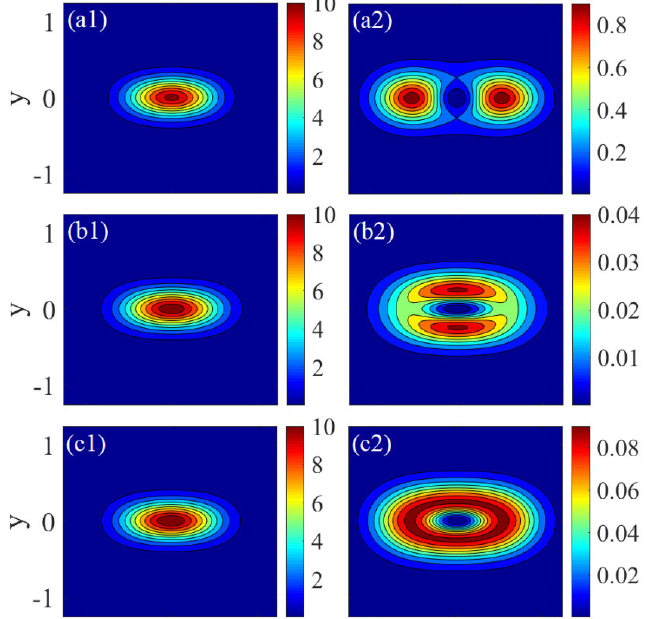
Figure 5. Symmetric vortex solitons (SVS) with N = 5. ( a ) Fundamental ( a1 ) and vortex ( a2 ) component of SVS with Ω = 0; ( b ) with Ω = 10; ( c ) with Ω = 4.23